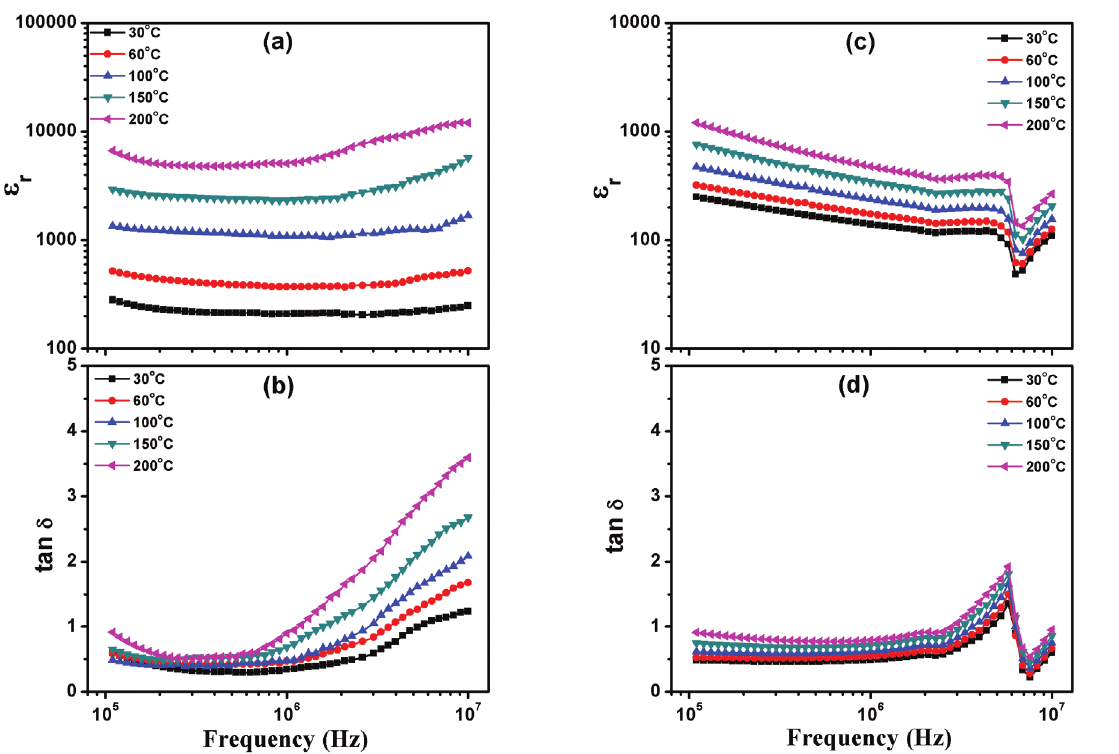
and dielectric loss tan δ for ( a ) and ( b ) SmCTO25 and ( c ) and ( d ) SmCTO50. r